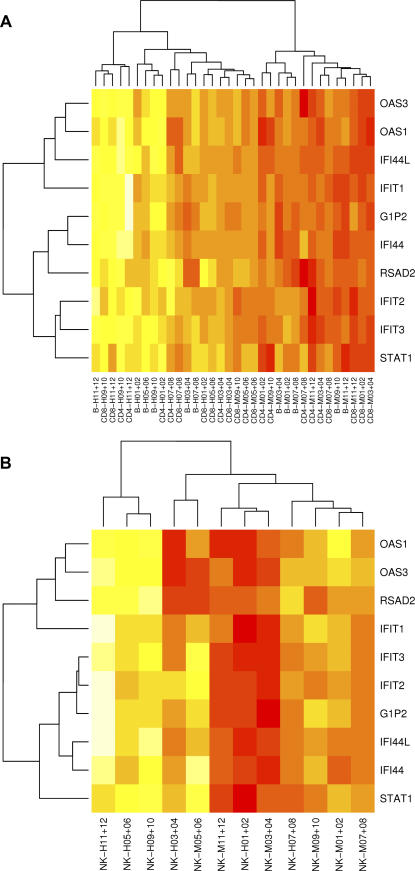
Hierarchical Clustering of the Microarray Data Using ISGsHierarchical clustering of the microarray data was performed using the ten ISGs with lowest adjusted p-values in combined data from B cells, CD8 T cells, and CD4 T cells (A) and CD56dim NK cells (B) from patients with melanoma versus healthy controls. White indicates highest expression, red indicates lowest, and yellow/orange indicates intermediary expression in melanoma versus healthy control.